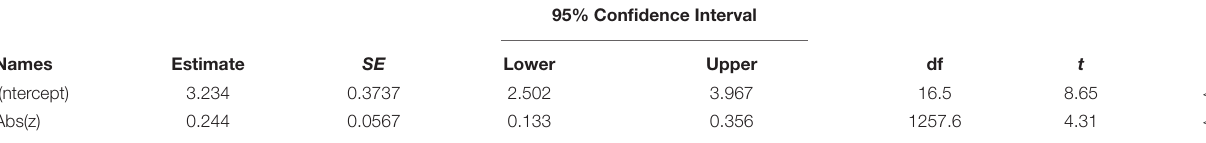
TABLE 2 | Fixed effects parameter estimates for model using tail